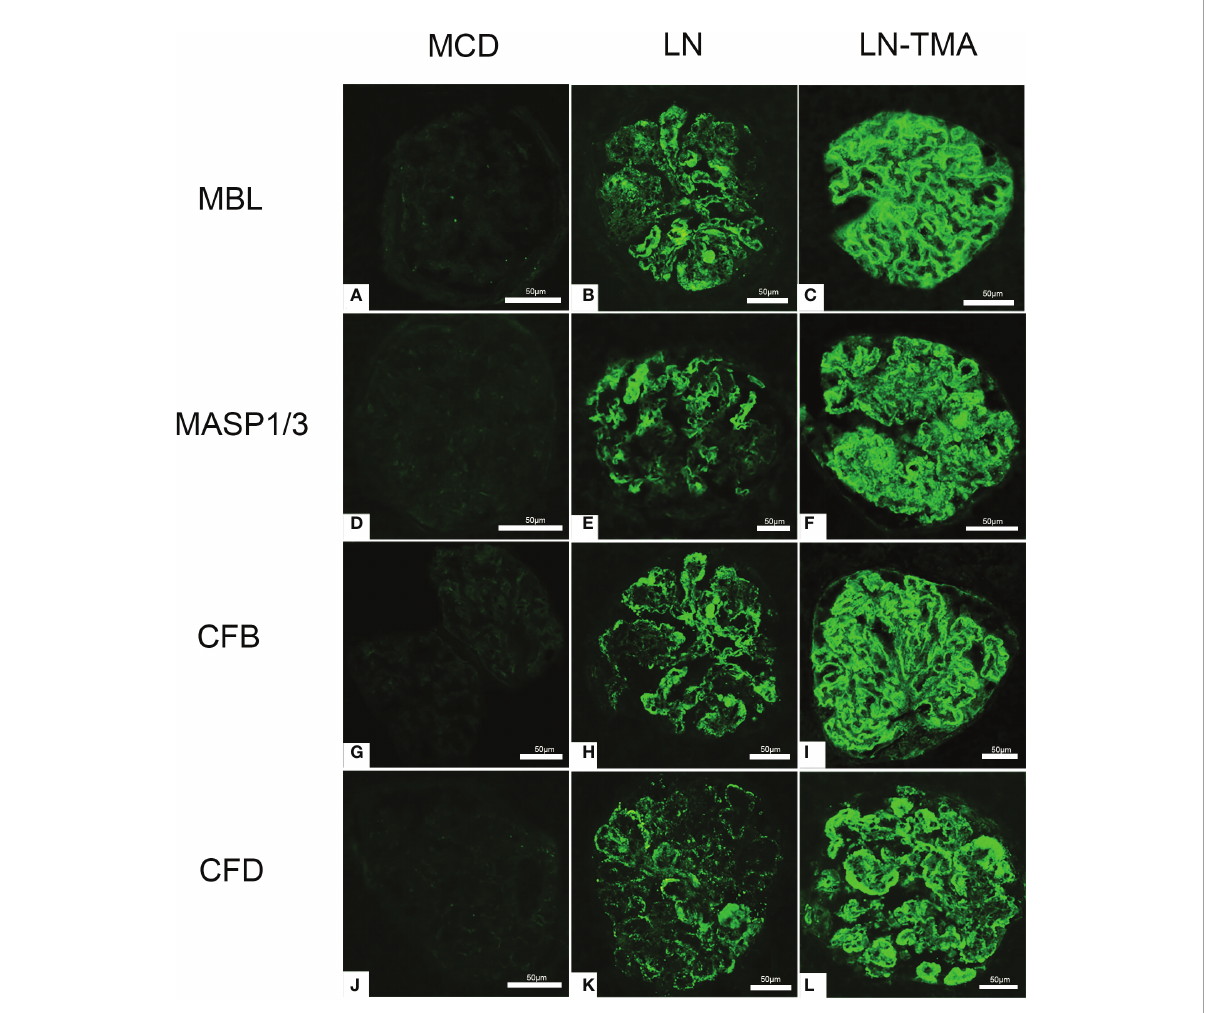
FIGURE 5 Immuno fl uorescence staining for MBL (A-C) , MASP1/3 (D-F) , CFB (G-I) , and CFD (J-L) among MCD, LN, and TMA groups. (A, D, G, J) Staining for MBL, MASP1/3, CFB, and CFD was negative in MCD renal tissues. (B, E, H, K) Moderate granular positive staining for MBL, MASP1/3, CFB, and CFD along the glomerular capillary and mesangial region in LN renal tissues. (C, F, I, L) Strong granular positive staining for MBL, MASP1/3, CFB, and CFD along the glomerular capillary and mesangial region in TMA renal tissues. Scale bars represent 50 m